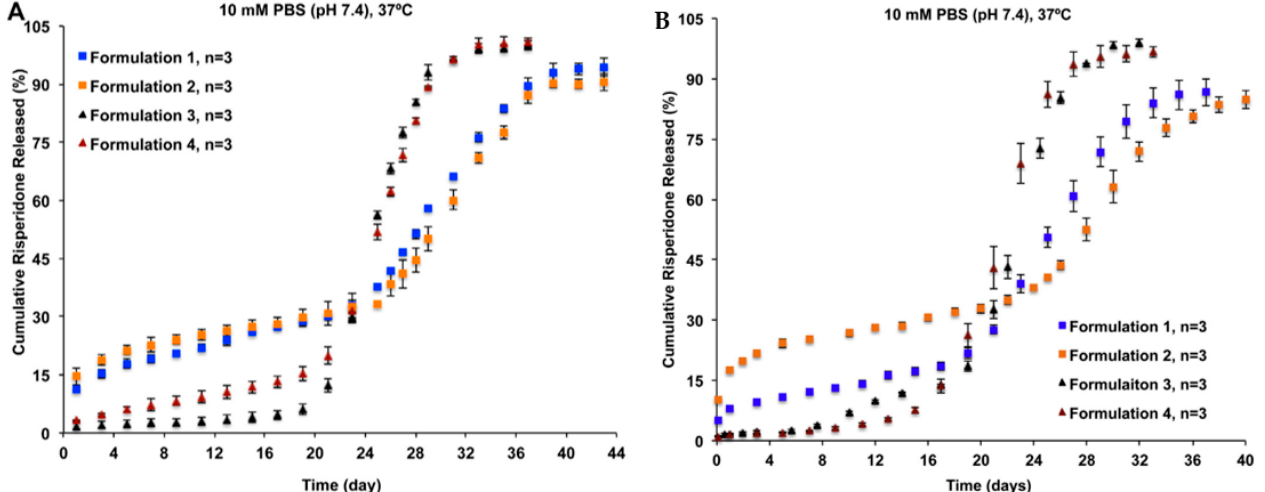
Figure 1. ( A ) The sample-and-separate method, and ( B ) the continuous flow method used in discrimination of the in vitro release profiles of risperidone from four PLGA microsphere formulations with equivalent compositions but different manufacturing processes. In comparison to the sample-and-separate method, the continuous flow method can better differentiate the release of risperidone ascribing to the porosity of microspheres (i.e., Formulations 3 and 4 vs. Formulations 1 and 2), as well as their particle sizes (i.e., Formulations 1 vs. 2). (Reprinted from Journal of Controlled Release , 218, Jie Shen, Stephanie Choi, Wen Qu, Yan Wang and Diane J. Burgess, In vitro-in vivo correlation of parenteral risperidone polymeric microspheres, 2–12, Copyright (2015), with permission from Elsevier [18]).